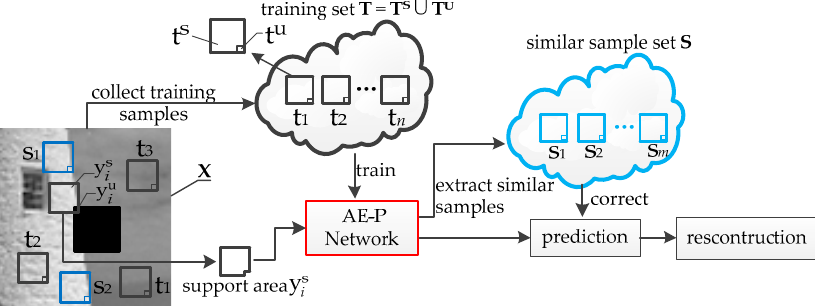
Figure 2. Block diagram of the proposed method. The missing pixel y u is under process. The square patches t i ( i = 1,2, ... , n ) are the collected samples for training. The square patches s i ( i = 1,2, ... , m ) are the samples that are similar to the current support area s i y .